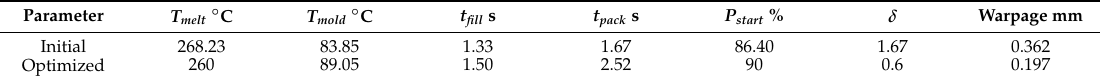
Table 10. Conventional parameters and warpage results of the PC light cover.